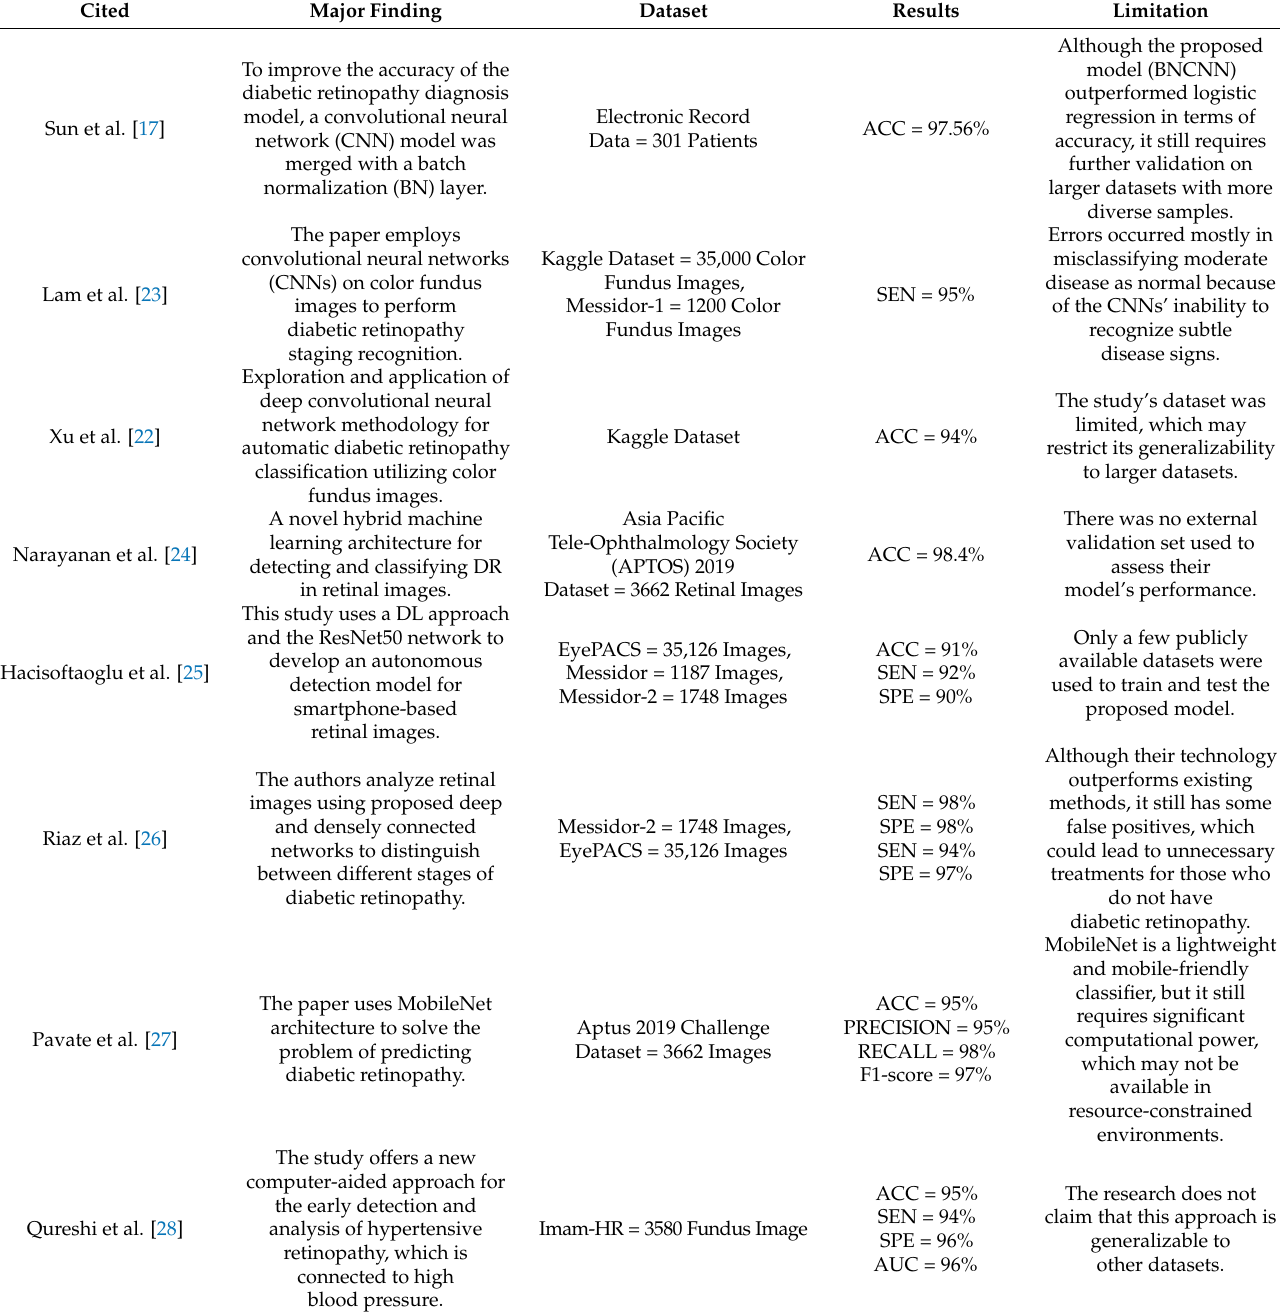
Table 9. Limitations of the state-of-the-art-work on hypertensive